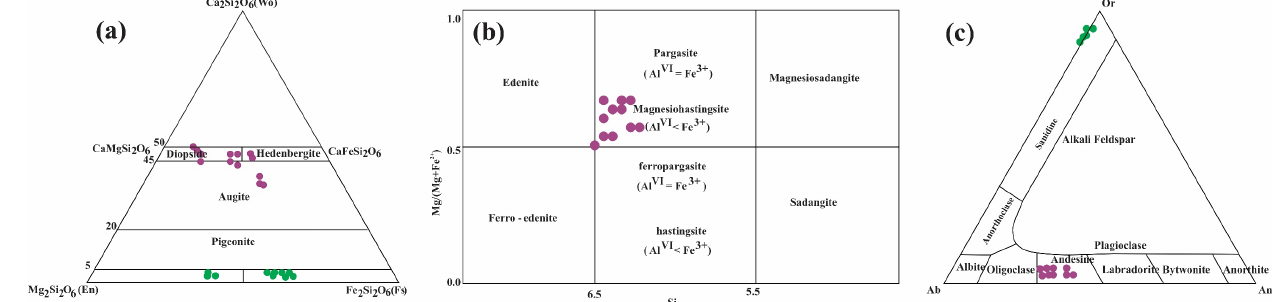
Figure 7. ( a ) Wollastonite-enstatite-ferrosilite diagram showing compositions of orthopyroxene (green circle) and clinopyroxene (maroon circle). ( b ) Anorthite-albite-orthoclase diagram showing compositions of orthoclase (green circle) and plagioclase (maroon circle), ( c ) Si (pfu) vs. X Mg diagram showing compositions of calcic amphibole.